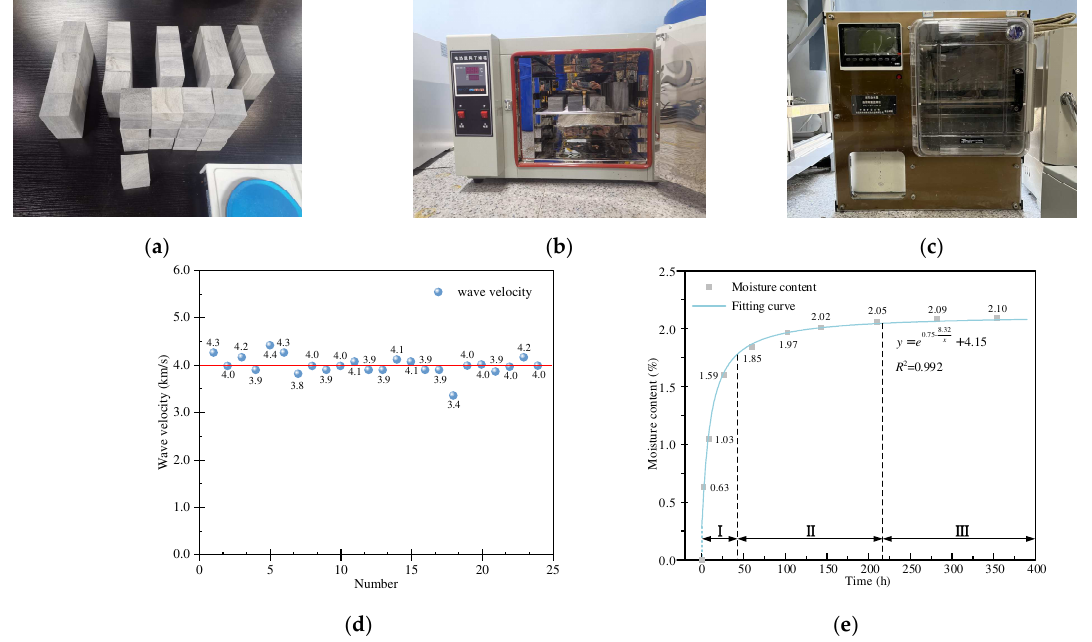
Figure 3. Pre-test treatment: ( a ) specimen weighing; ( b ) specimen drying; ( c ) nondestructive water immersion device; ( d ) wave velocity test results; ( e ) variation in moisture content with immersion time.